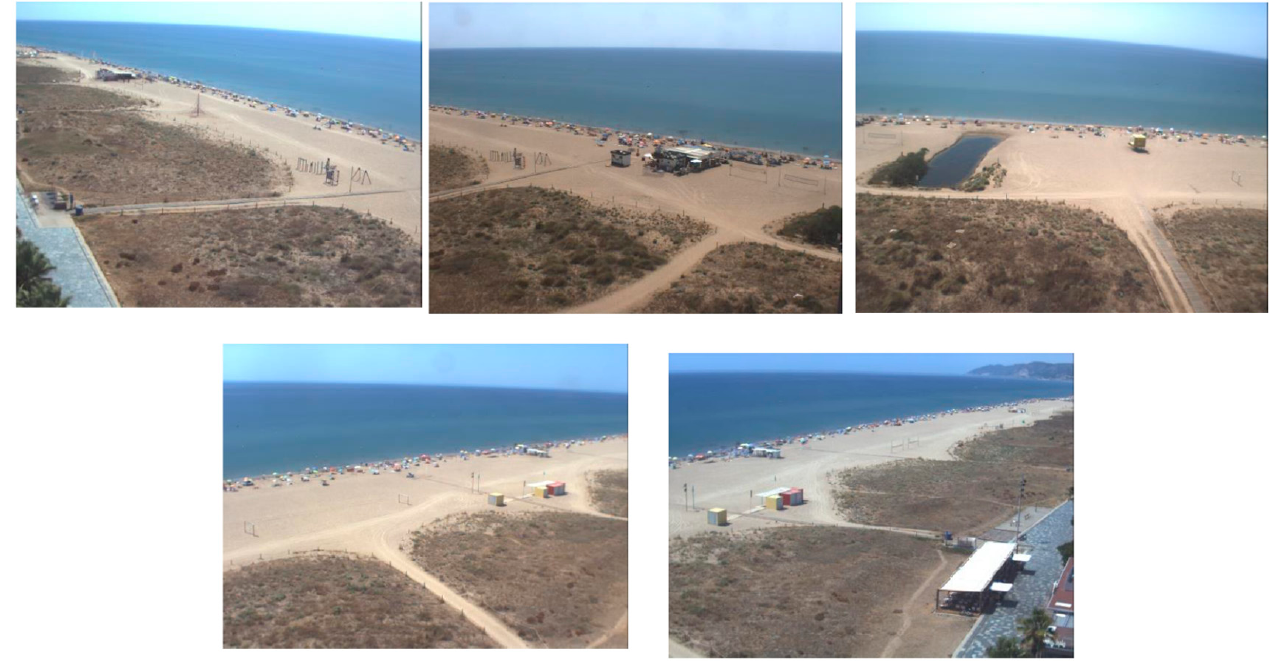
Figure 2. Example of the images captured by the five video cameras.